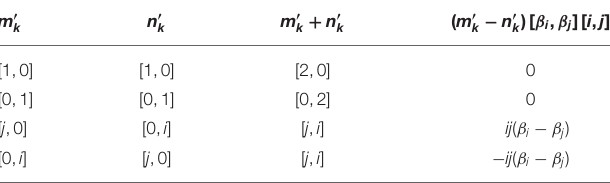
TABLE 1 | Context-derived heterogeneous functions of monocyte